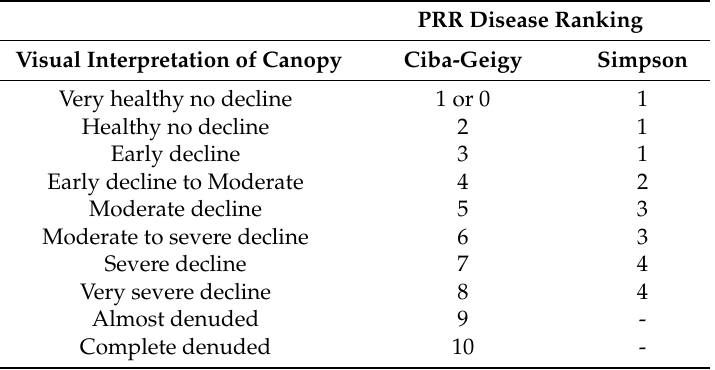
Table 1. Ciba-Geigy and Simpson ranks used for visual estimation of Phytophthora root rot (PRR) disease severity (proportion of canopy